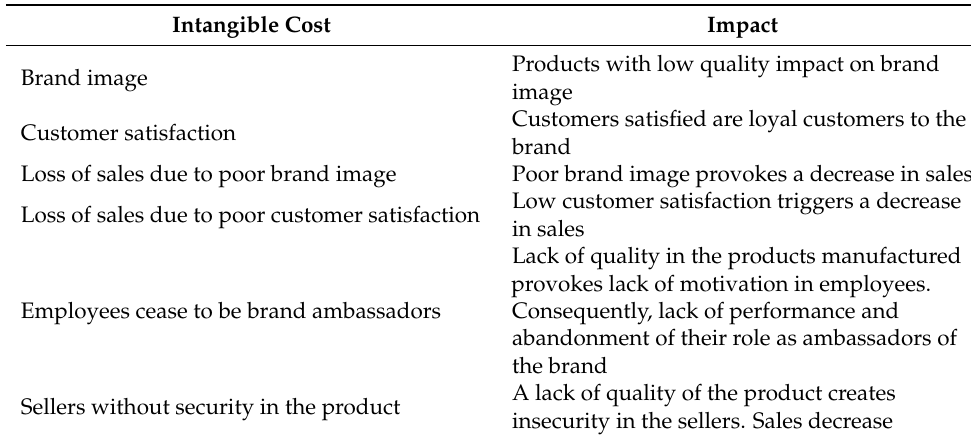
Table 3. List of intangible costs and impacts